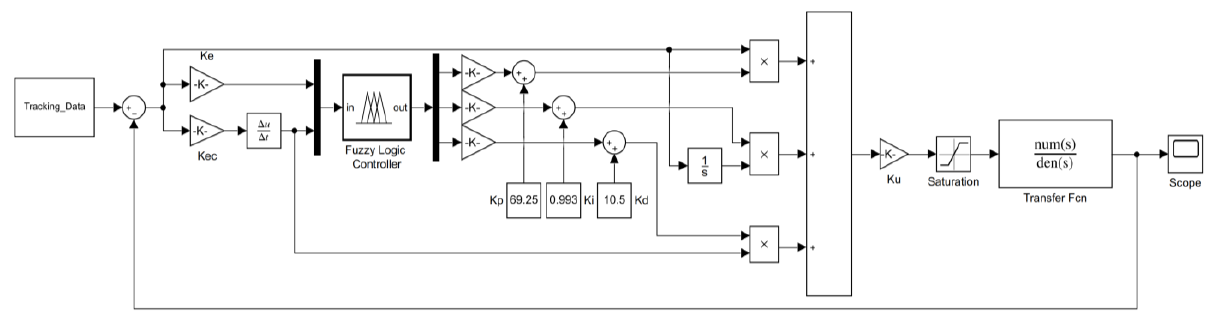
Figure 8. Blocks of the fuzzy self-tuning PID control algorithm.